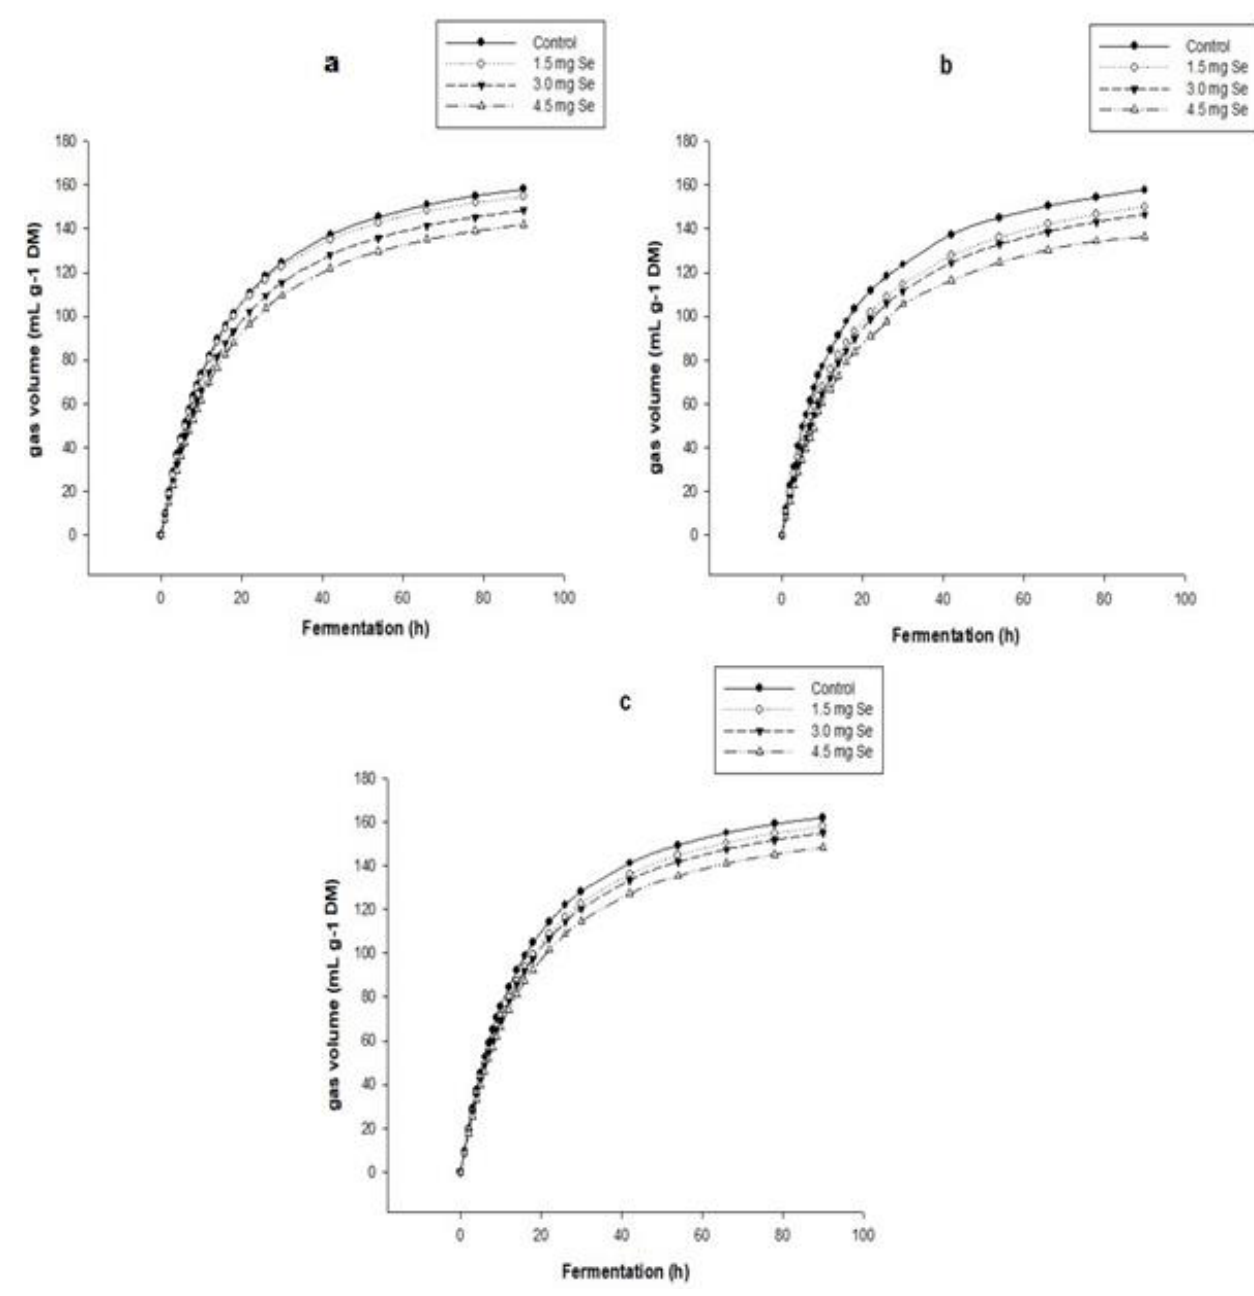
Figure 1. Cumulative total gas production profile during the 92 h fermentation in the different treatments and harvests. ( a ) First harvest; ( b ) Second harvest; ( c ) Third harvest.